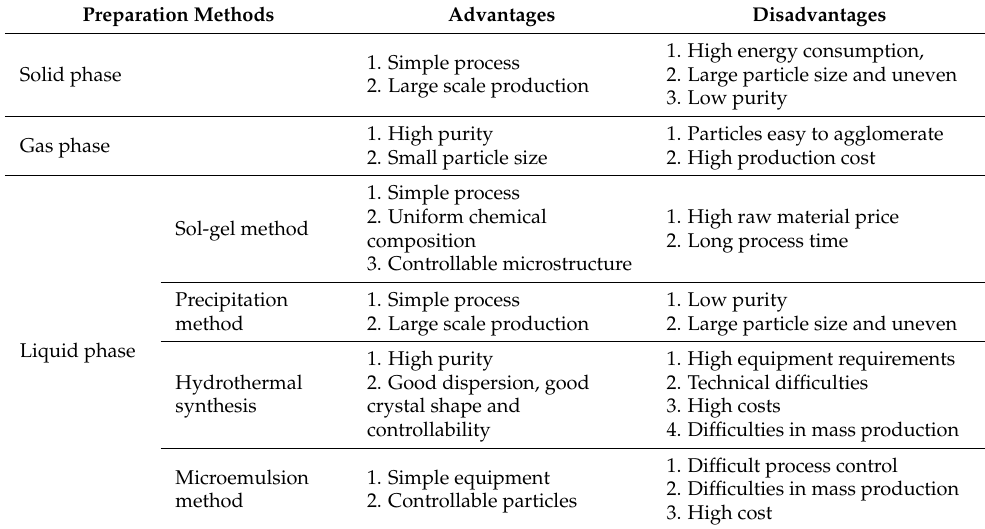
Table 1. The advantages and disadvantages of preparation methods of TiO 2